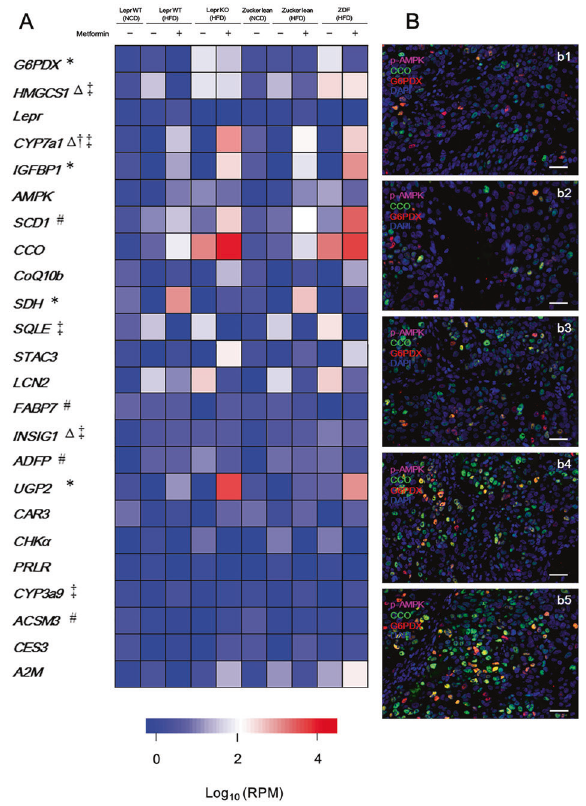
Fig. 6 Single-cell RNA sequencing and an immuno fl uorescence study of hepatocytes isolated from rats (as indicated). A Single-cell RNA sequencing: 24 genes with the greatest difference between metformin-treated Lepr WT rats and Lepr-KO rats. n = 12. *Glucose